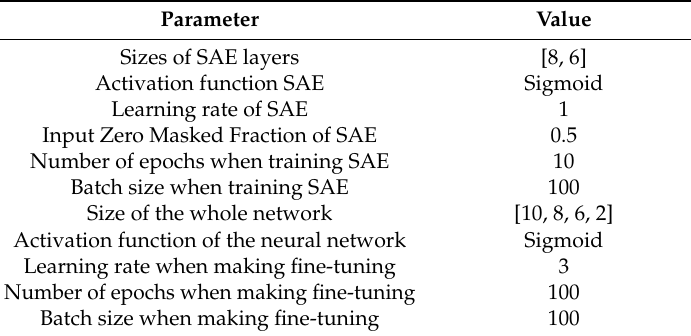
Table 4. Parameter settings of the stacked autoencoder (SAE).